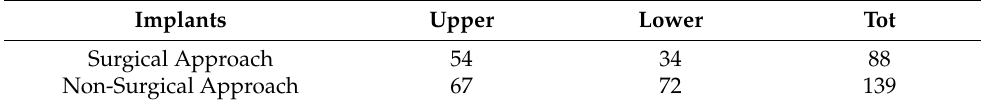
Table 3. Number of implants for the two